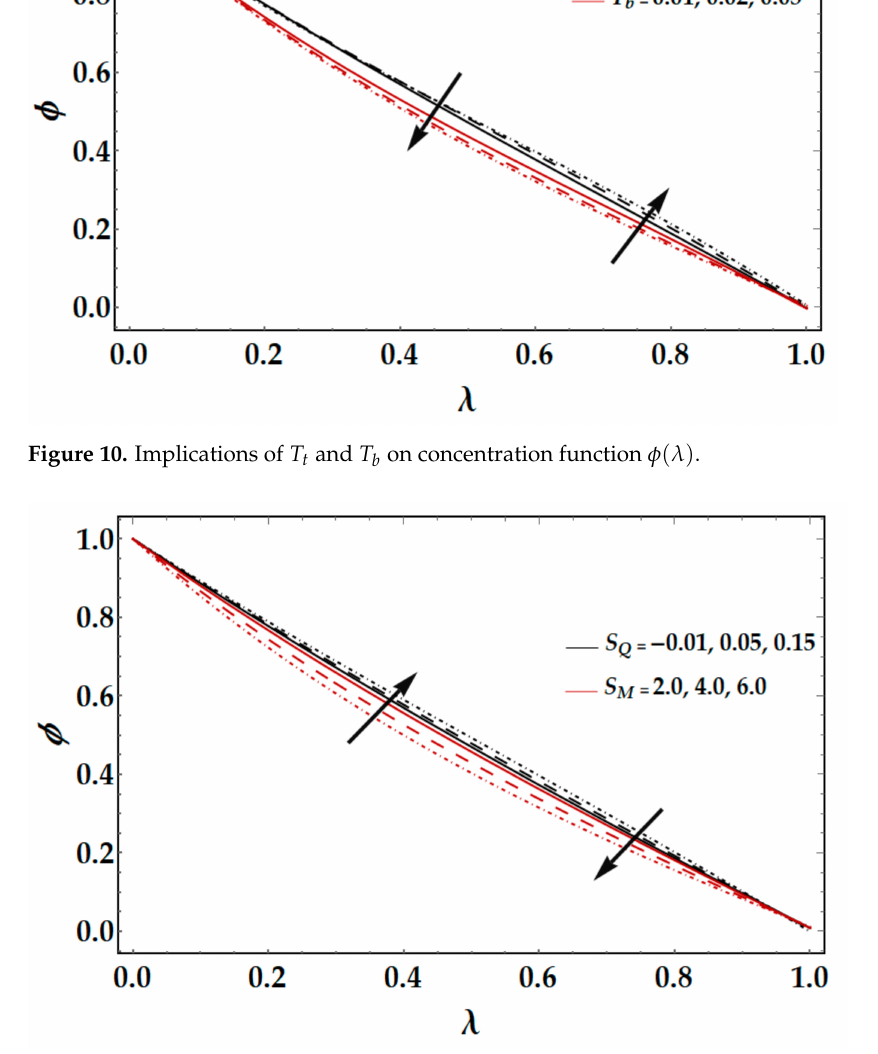
Figure 11. Implications of S Q , S M on concentration function φ ( λ )